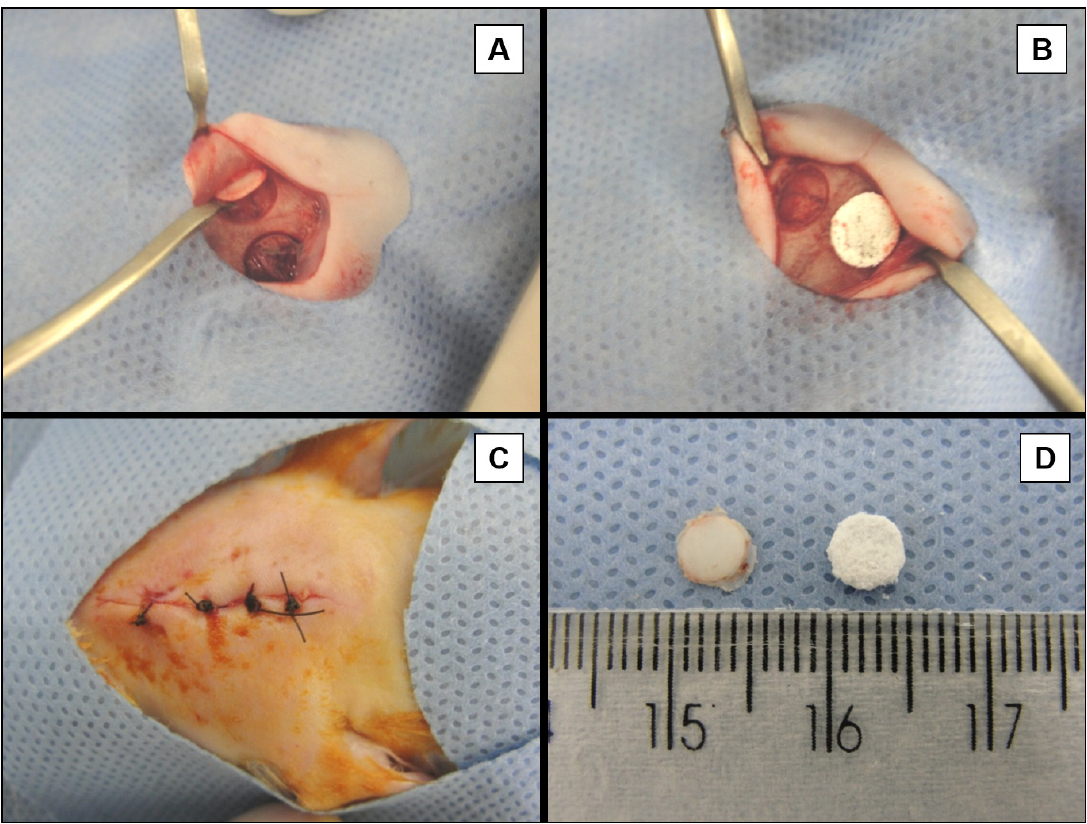
Figure 1. (A) Bilateral 5 mm critical-size calvarial defects created using a surgical trephine drill. (B) Implant of the PLDLA construct into the defect on the right; the left defect was empty and served as the control. (C) Suture. (D) Comparison of native calvarial and polymeric